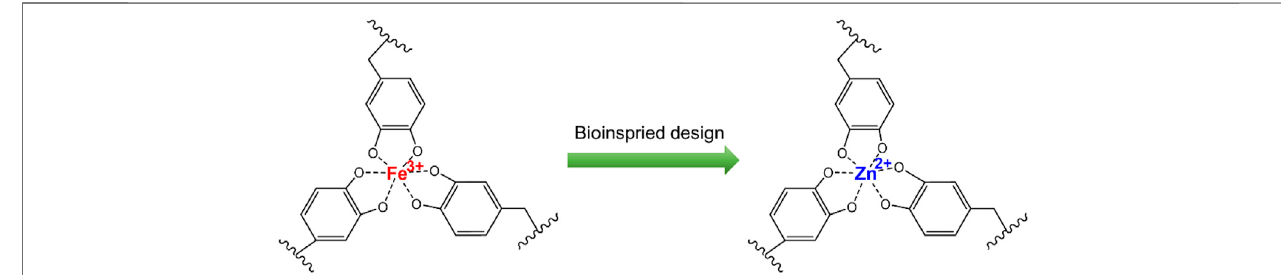
FIGURE 1 | Schematic diagram of the formation of the dopamine – Zn 2+